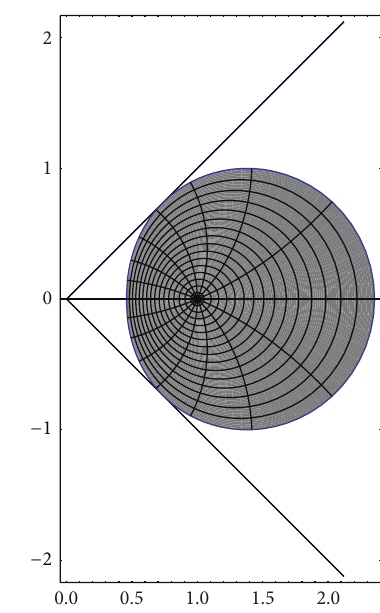
Figure 5: Image of |𝑧| ≤ 0.266747 touches | arg 𝑤| = 𝜋/4